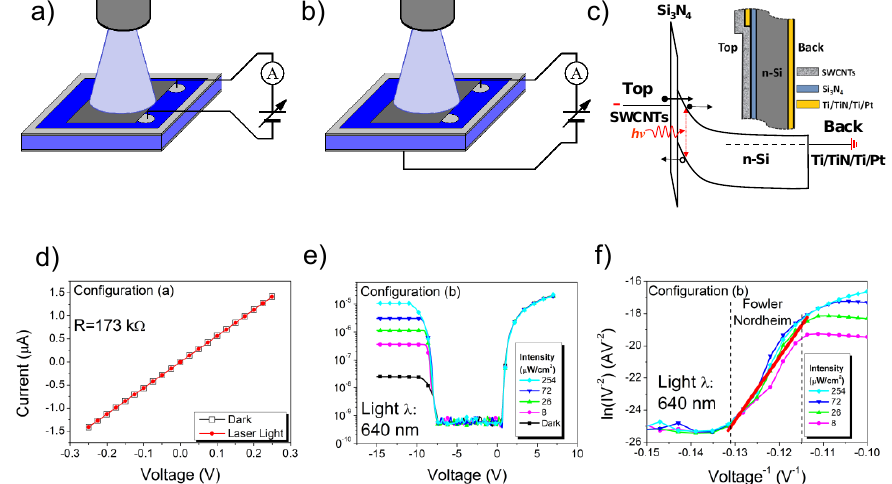
Figure 5. ( a ) Pad to pad horizontal measurement configuration and ( b ) top–back vertical measure- ment configuration. ( c ) Band diagram of the device in reverse bias showing tunneling through the top barrier and photogeneration in the top depletion layer (the back contact is ohmic). The cross section of the device is also shown. ( d ) IV characteristics of the SWCNT film (configuration a) in the dark and under illumination by a white light (wavelength in the range 450 nm to 2400 nm and intensity 2 W/cm 2 ). ( e ) IV curves of SWCNT − Si 3 N 4 − Si MIS structure in configuration b) (top-back) under 640 nm light at different light intensities. ( f ) Fowler–Nordheim plot of the IV curves of the SWCNT − Si 3 N 4 − Si MIS structure around V = − 7.5 V (the red straight-line Y = a + b X = 26 + 392 X is the fit of 26 µ W/cm 2 data–green